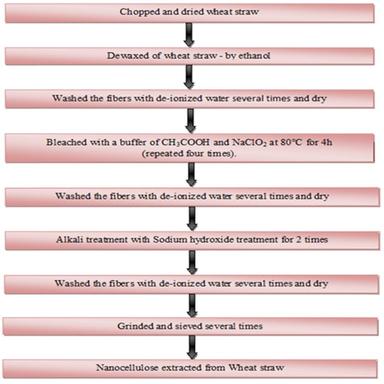
Methodology used to extract nanocellulose from wheat straw.